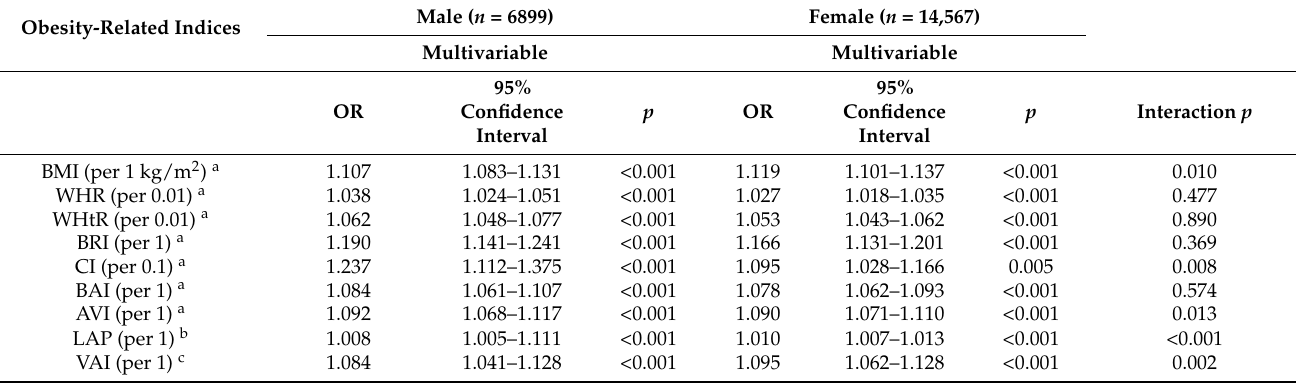
Table 5. The following models were used: Table 5. Association of obesity-related indices with incident hypertension using multivariable logistic regression